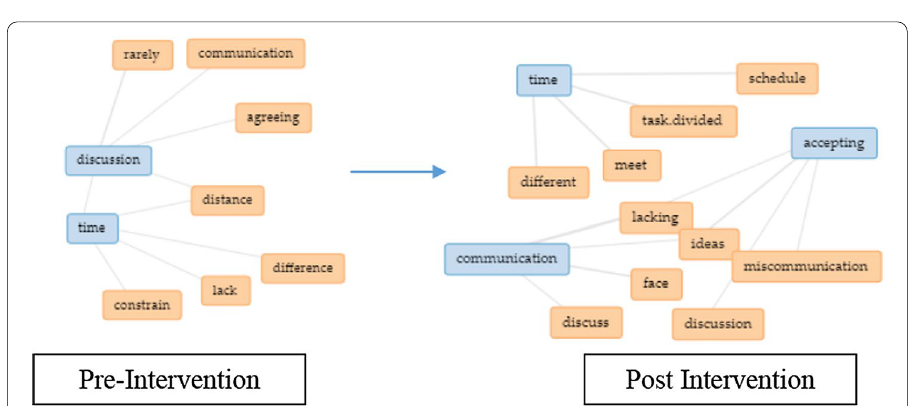
Fig. 11 Change in perception for the CT group based on issues faced as a